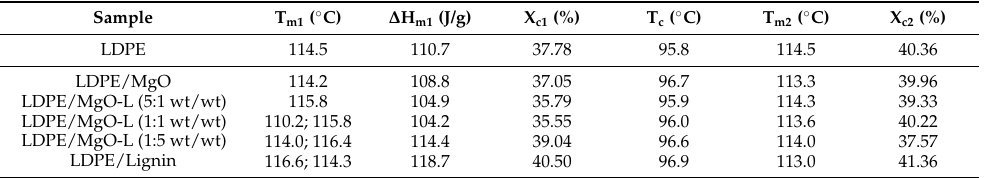
Figure 2. The DSC curves obtained during the first heating of ( a ) pristine LDPE, ( b ) LDPE/MgO, ( c ) LDPE/MgO-L (5:1 wt/wt), ( d ) LDPE/MgO-L (1:1 wt/wt), ( e ) LDPE/MgO-L (1:5 wt/wt), and ( f ) LDPE/lignin. Table 2. Calorimetric parameters from first heating, cooling, and second heating scans for all